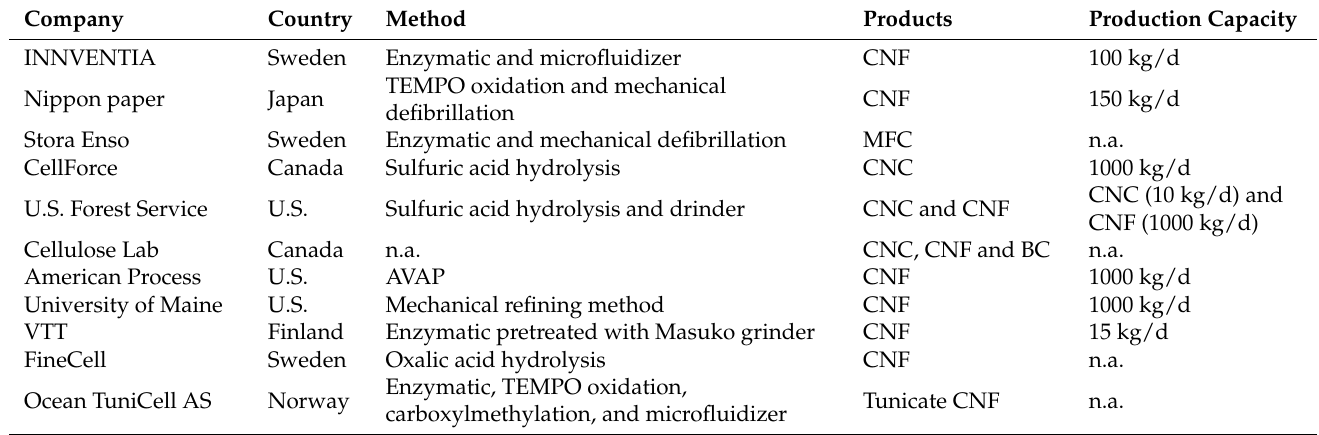
Table 6. Global nanocellulose production facilities with their products and